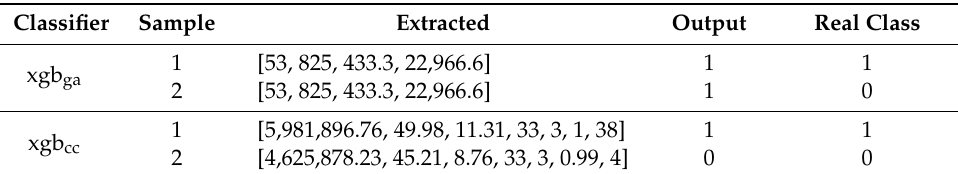
Table 14. Example of samples’